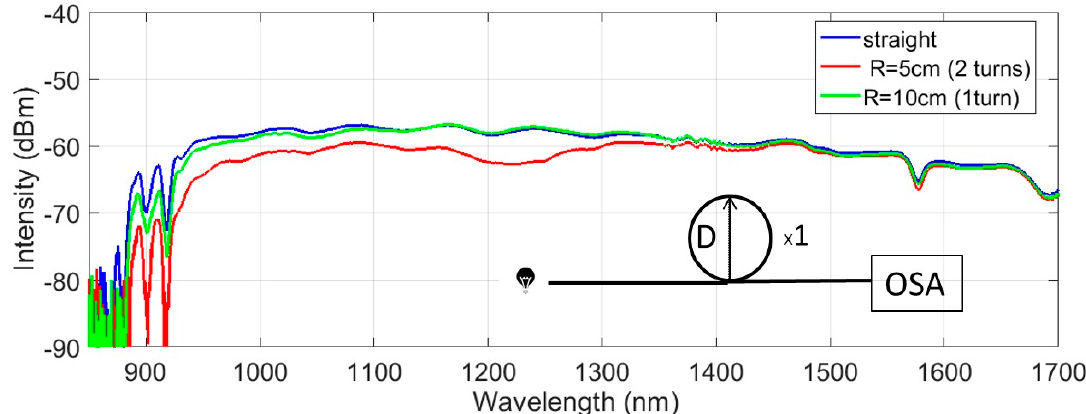
Figure 3. Comparison of the optical transmission spectrum of 1.7 m of borosilicate based hollow-core optical fibers (HC), for different bend radii R : loosely coiled fiber (blue line), R = 10 cm (green line, 1 full turn) and R = 5 cm (red line, 2 full turns).